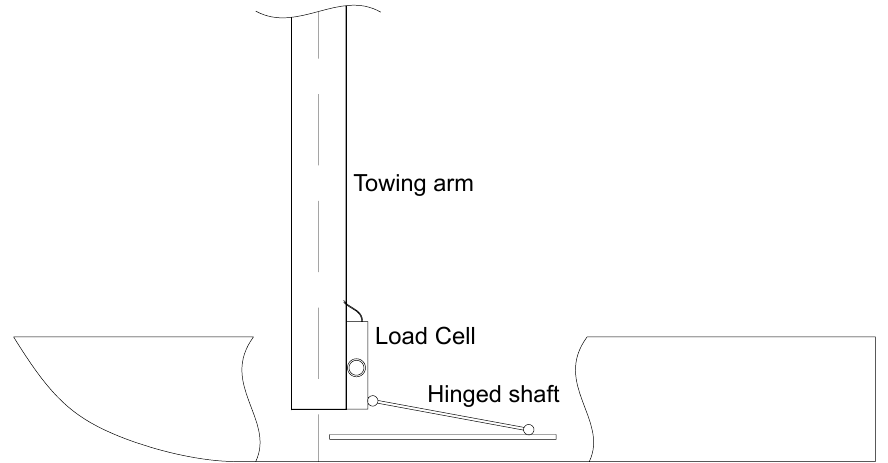
Figure 2. Experimental matrices of wave frequency and steepness for each hull and speed combination.